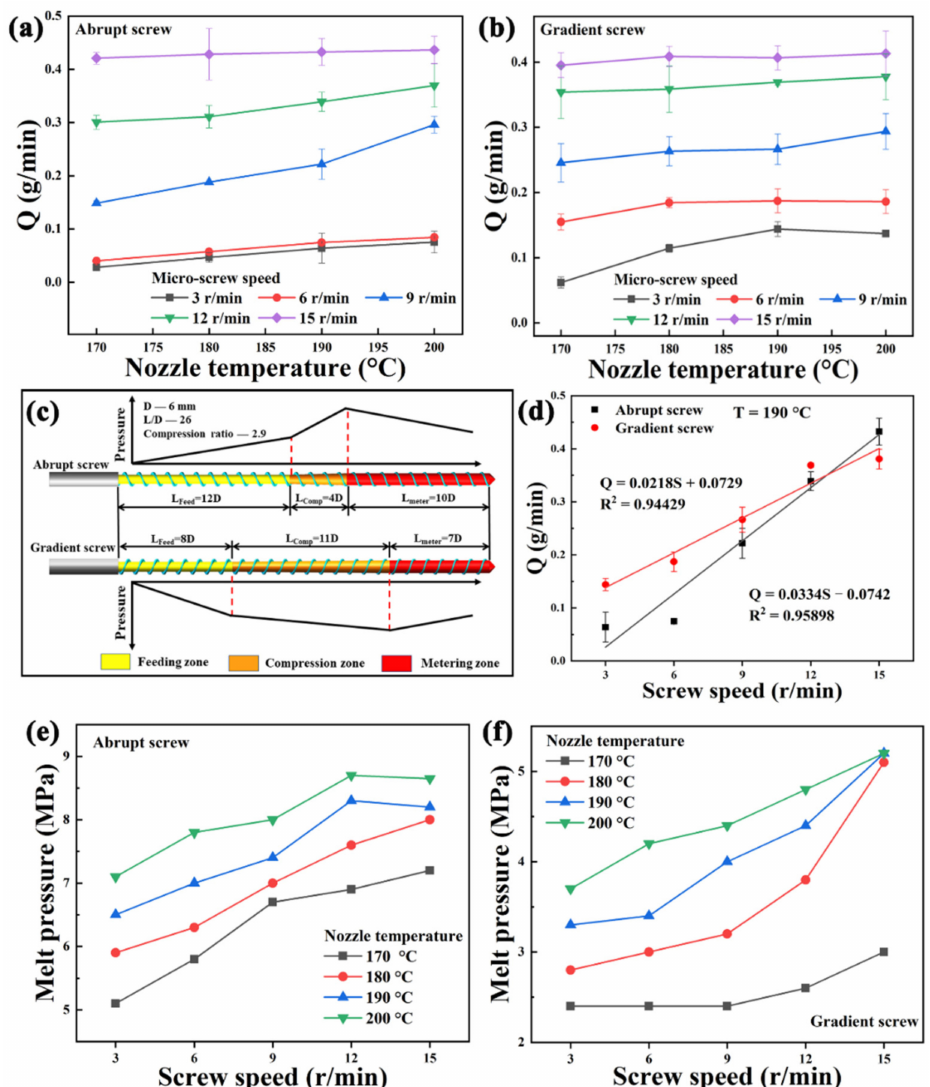
Figure 4. Extrusion stability curves of ( a ) abrupt screw and ( b ) gradient screw extruded at various nozzle temperatures and screw speeds. ( c ) Schematic diagram of pressure gradient curves and the structural parameters of two micro-screws. ( d ) Q-S curves of two kinds of screws at the nozzle temperature of 190 ◦ C. Melt pressure curves of ( e ) abrupt screw and ( f ) gradient screw at various nozzle temperatures and screw